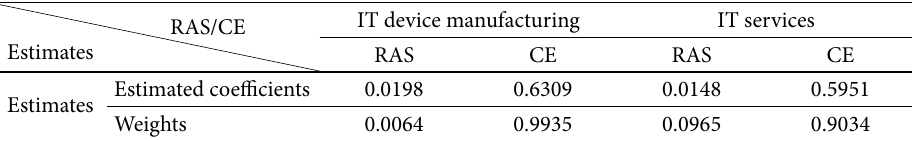
Table 2. Estimates of the IT device manufacturing and IT service sectors